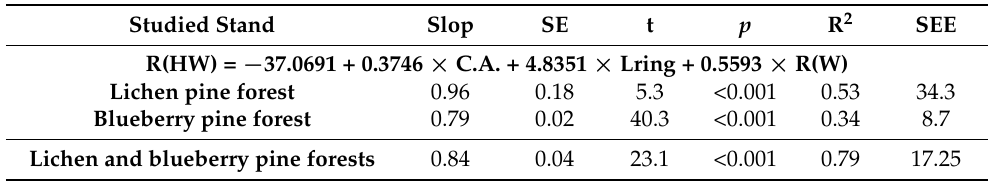
Table 7. The model developed for lingonberry pine forest [45] describes the heartwood radius as a function of cambium age, Lring and R(W) for Scots pine and general statistics for lichen and blueberry pine